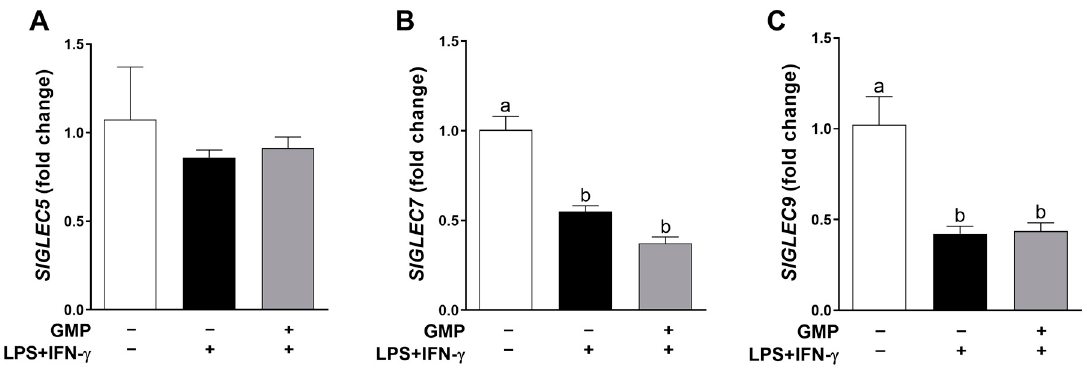
Figure 5. Effect of pretreatment with GMP on macrophage expression level of Siglec receptors. Expression level of ( A ) SIGLEC5 , ( B ) SIGLEC7 , and ( C ) SIGLEC9 receptors relative to GAPDH was analyzed by quantitative PCR and expressed as fold change ( n = 3 independent experiments). Means followed by different letters (a, b) are significantly di ff erent.